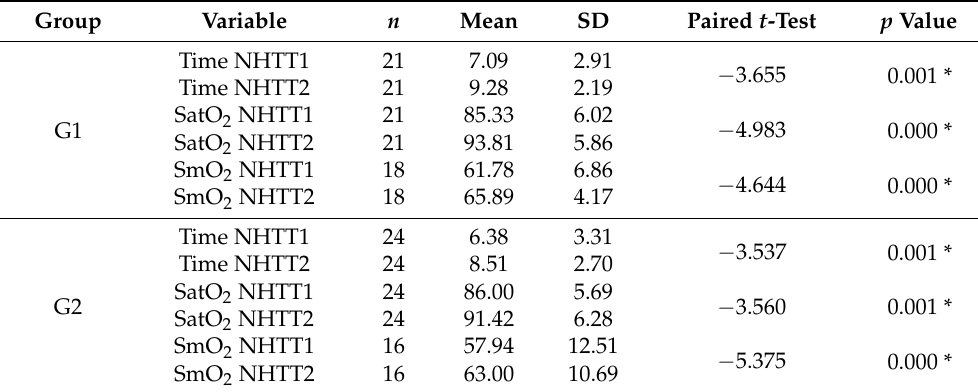
Table 6. Differences between the first and second tests by